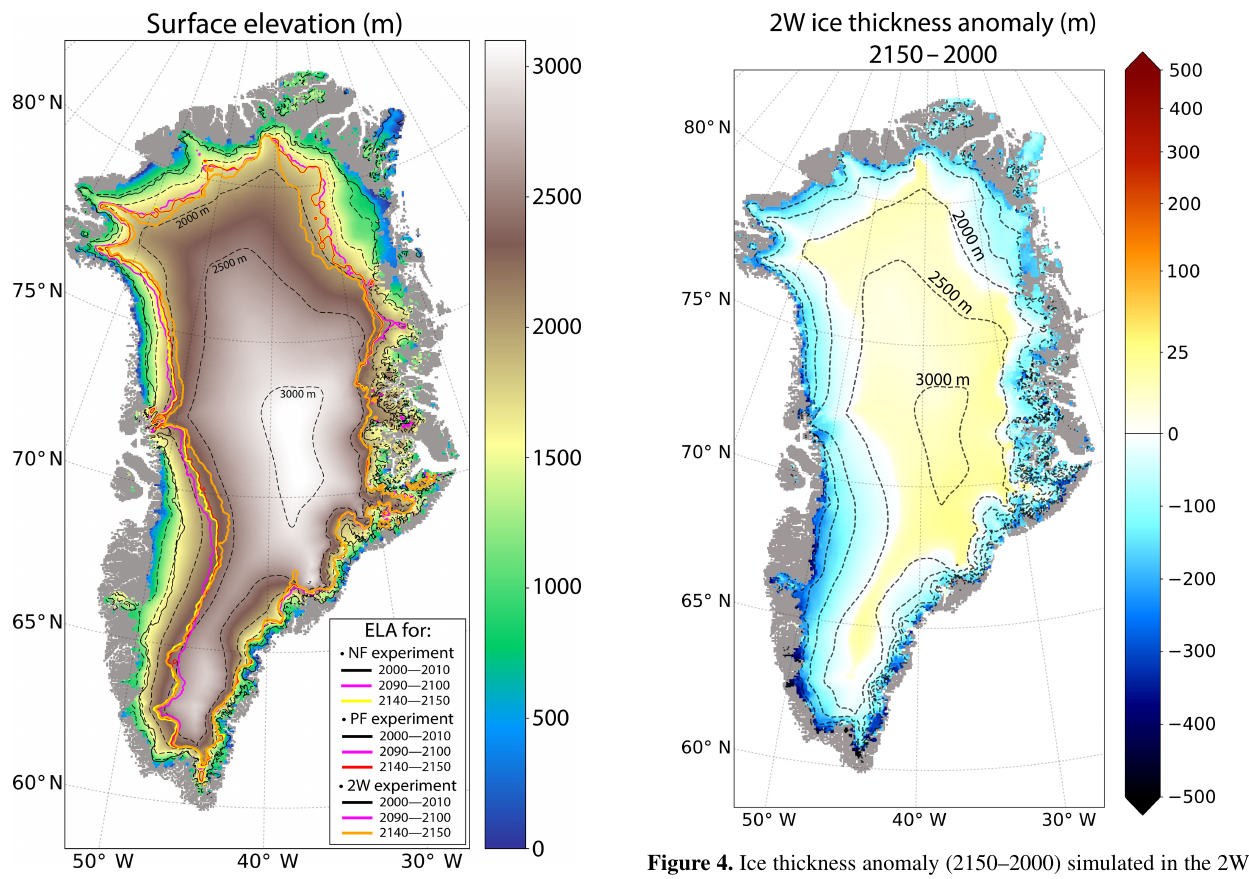
Figure 3. GrIS surface elevation in 2150 simulated in the 2W ex- periment (in m). The solid black and purple lines represent the equi- librium line altitudes (ELA, limit between the accumulation and the ablation zones) in the 2000–2010 and 2090–2100 mean periods, re- spectively, for the NF, PF and 2W experiments. The yellow, red and orange solid lines indicate the ELA position over 2140–2150 for the NF, PF and 2W experiments, respectively. The dashed lines corre- spond to the 500m surface elevation iso-contours for the present- day observed topography. The grey shading represents the non ice- covered areas.